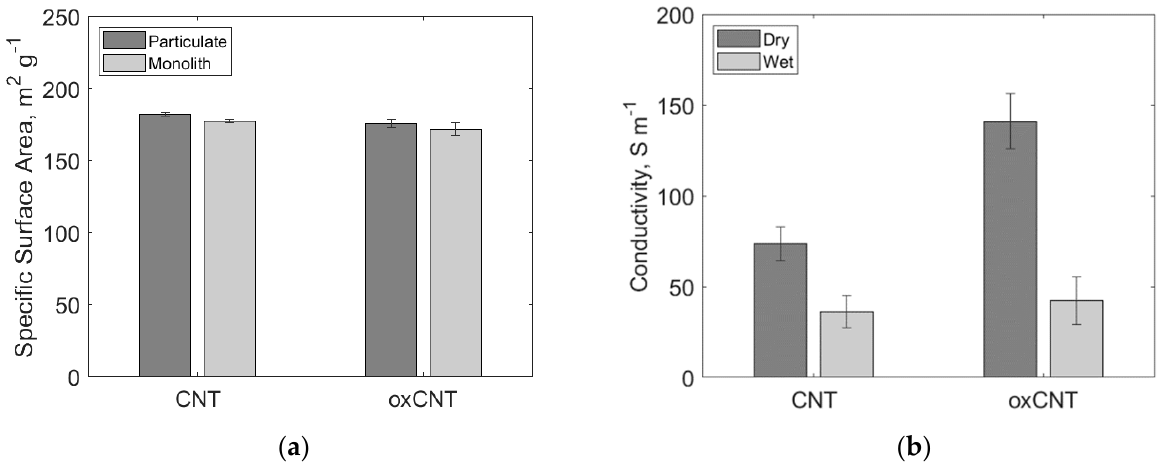
Figure 6. Specific surface area ( a ) and electrical conductivity ( b ) for untreated and oxidized monoliths.